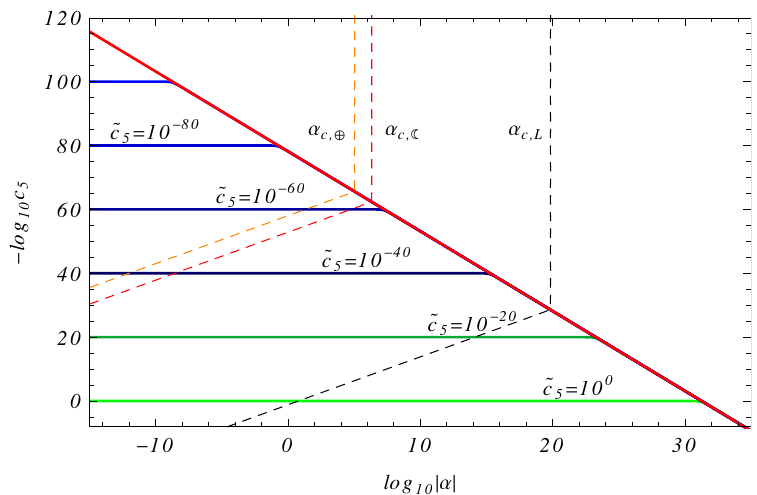
Figure 6 . Natural value of the quintic dimension-5 operator coe(cid:14)cient c 5 { (cid:3) (red, normalised to (cid:3) (cid:16) M Pl ), as a function of log | (cid:11) | . Possible UV tree-level contributions (green/blue contours) ~ c 5 10 are independent of (cid:11) . Also shown as dashed red, orange and black lines are contours of (cid:11) p 5 q c for the Moon, Earth and LAGEOS